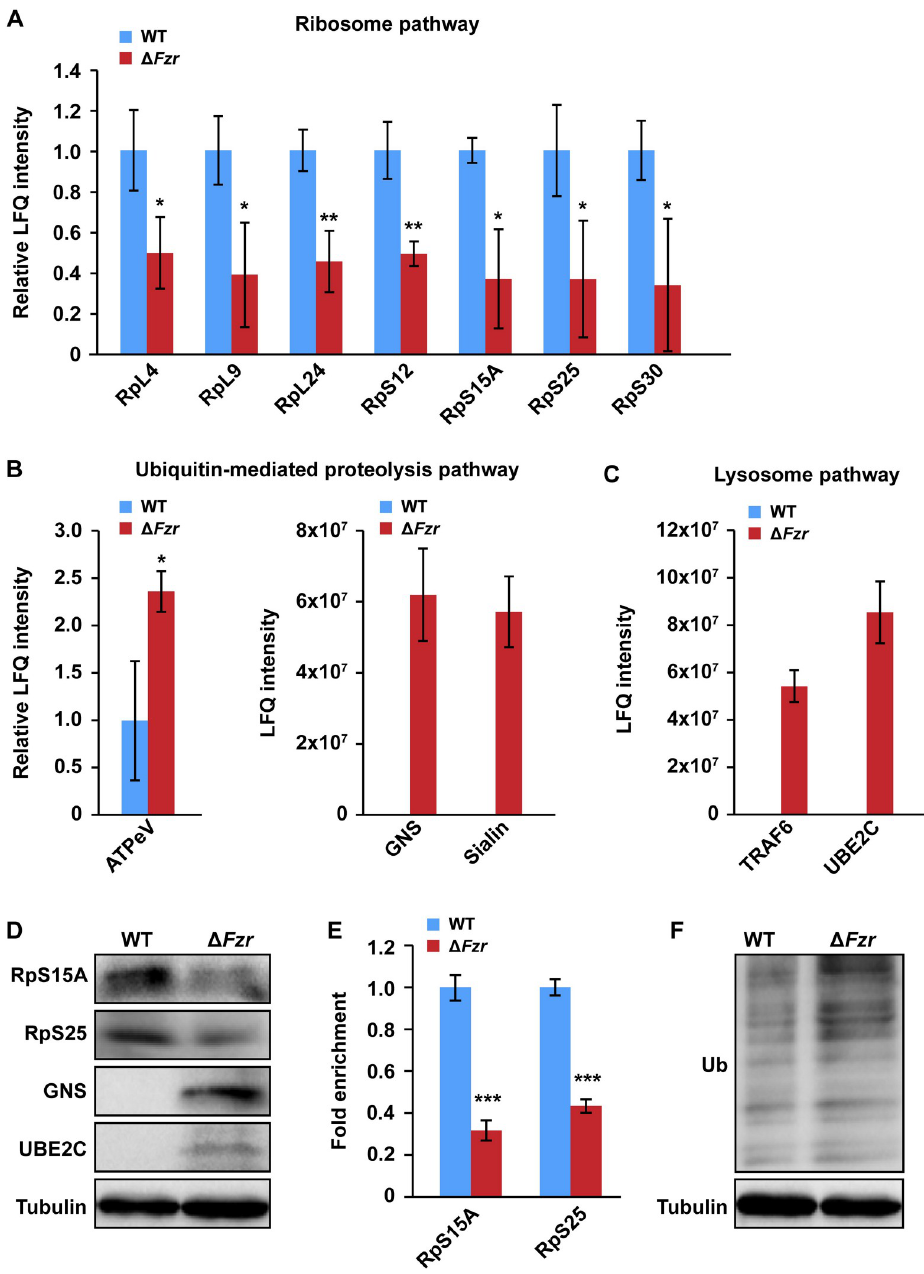
Fig 5. Fzr regulation on protein synthesis and degradation. ( A ) All DEPs in Ribosome pathway were downregulated in PSG cells following PSG-specific Fzr mutation. ( B-C ) DEPs in the ubiquitin-mediated proteolysis pathway (B) and lysosome pathway (C) were downregulated by Fzr mutation in the PSG. ( D ) Western blotting showed that RpS15A and RpS25 were downregulated, but GNS and UBE2C were elevated following Fzr mutation. ( E ) Translating ribosome affinity purification (TRAP) analysis showed that Fzr mutation inhibited mRNA translation in PSG cells. ( F ) Fzr mutation elevated protein ubiquitination in PSG cells. Values were represented as means ± S.E. (error bars). For the significance test: � P < 0.05, �� P < 0.01, and ��� P < 0.001 versus the control. WT, wild type.